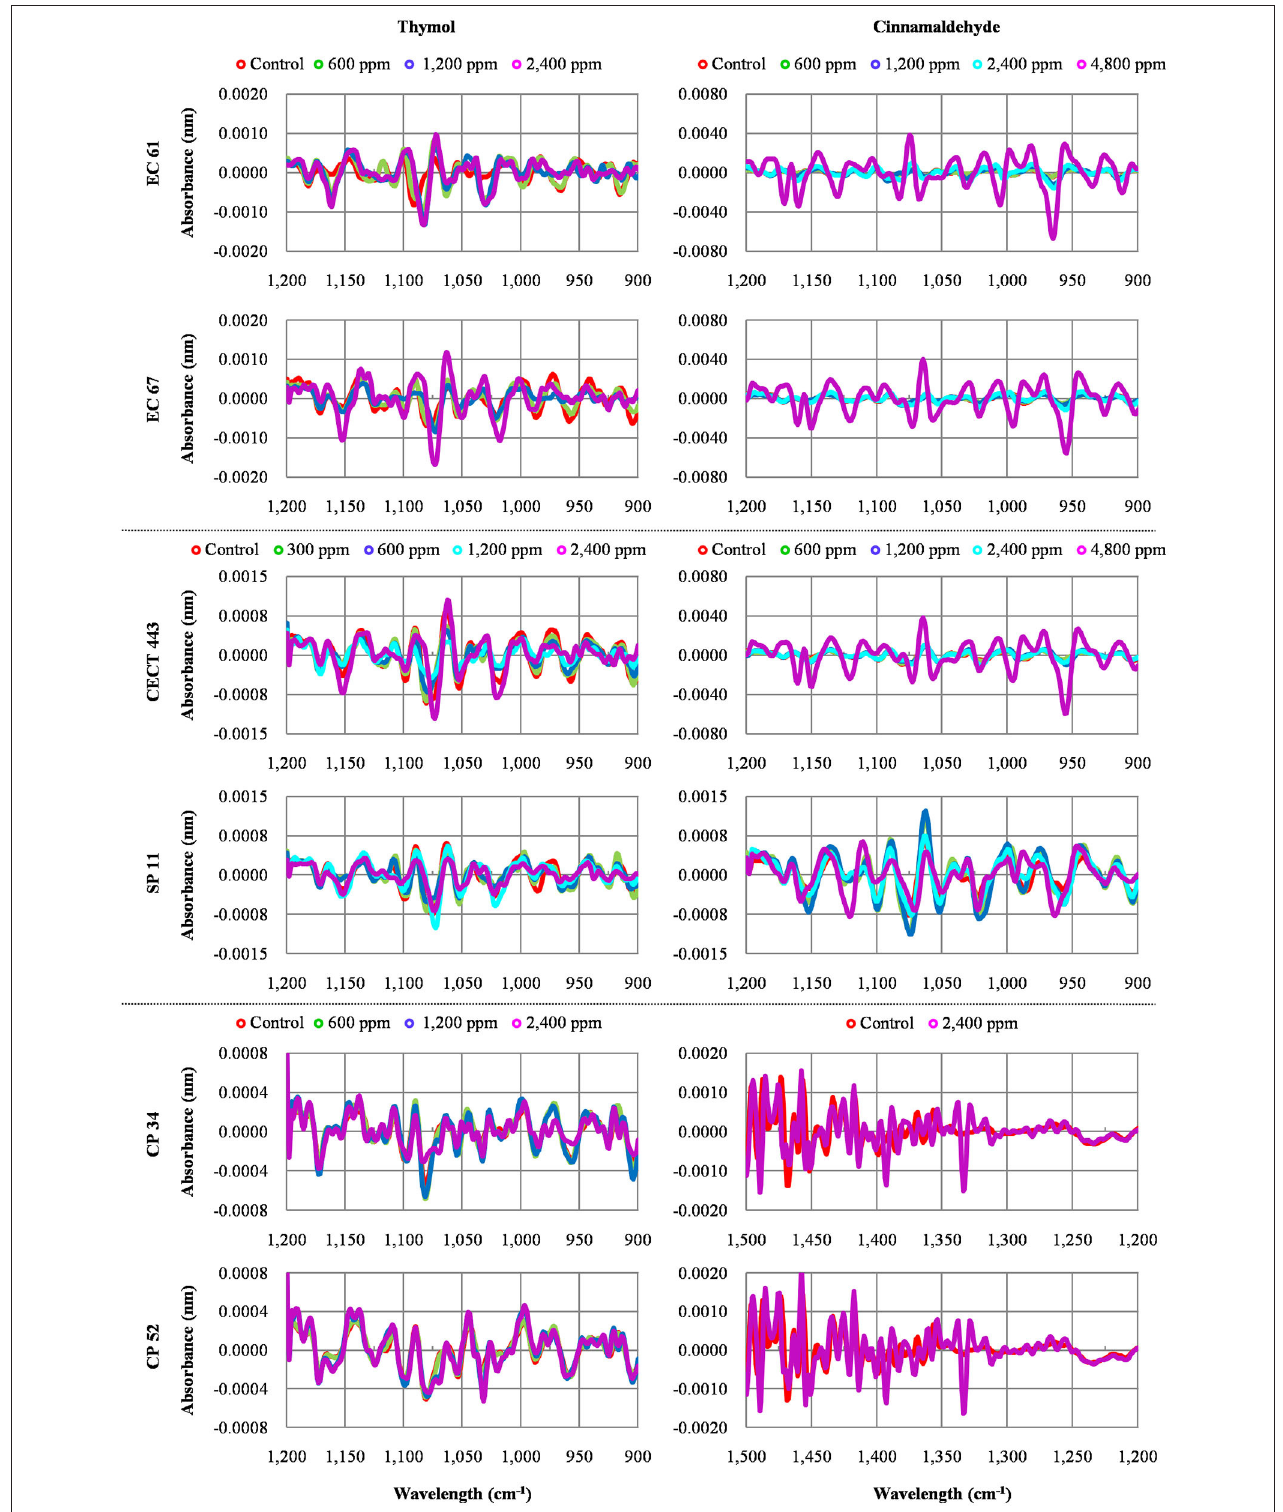
FIGURE 3 | Average values of Fourier Transform Infrared (FTIR) absorbance spectra of the three replicates of the selected windows obtained for each isolate tested after the exposure to different concentrations of thymol and cinnamaldehyde (green line, ½ MBC low ; blue line, MBC low ; light blue line, MBC high ; purple line, 2MBC high ) and without product (red line, control) for 90min at room